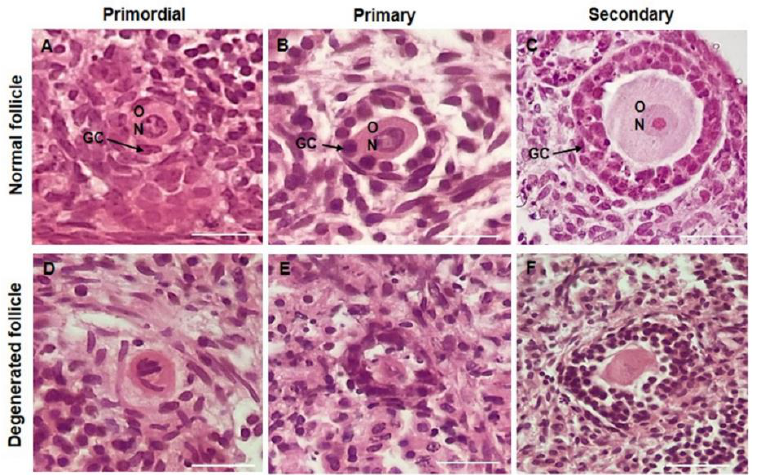
Figure 5. Representative images of ovarian sections of mouse cultured in vitro for 6 days showing a morphologically normal ( A – C ) and degenerated ( D – F ) follicles from different stages of develop- ment stained with haematoxylin and eosin. ( A ) Normal and ( D ) degenerated primordial follicles; ( B ) Normal and ( E ) degenerated primary follicles; ( C ) Normal and ( F ) degenerated secondary folliclse. Granulosa cells (GC); Oocyte (O); Oocyte nucleus (N). (400 × , Scale bar: 100 µ